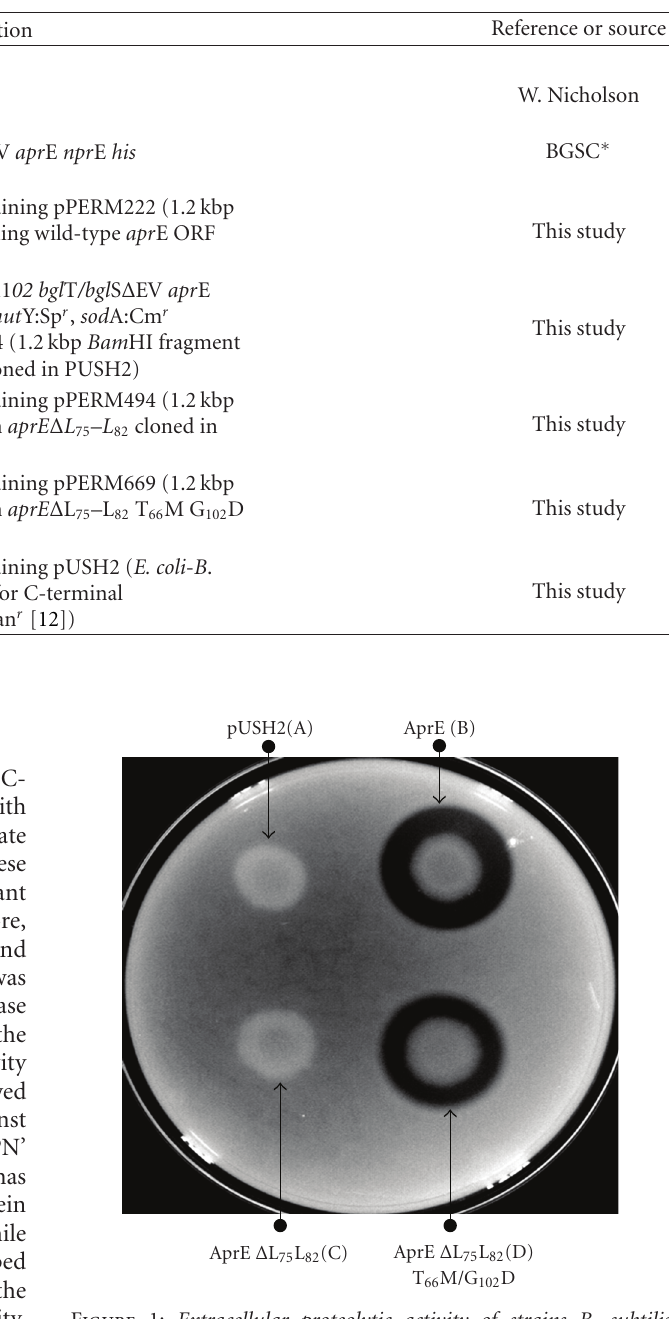
Table 1: Bacterial strains used in this study.